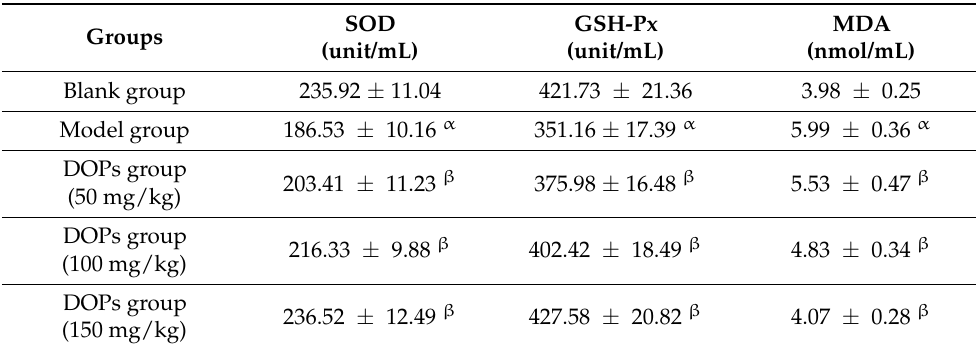
Table 3. Antioxidant enzymes activities and MDA contents of mice sera.